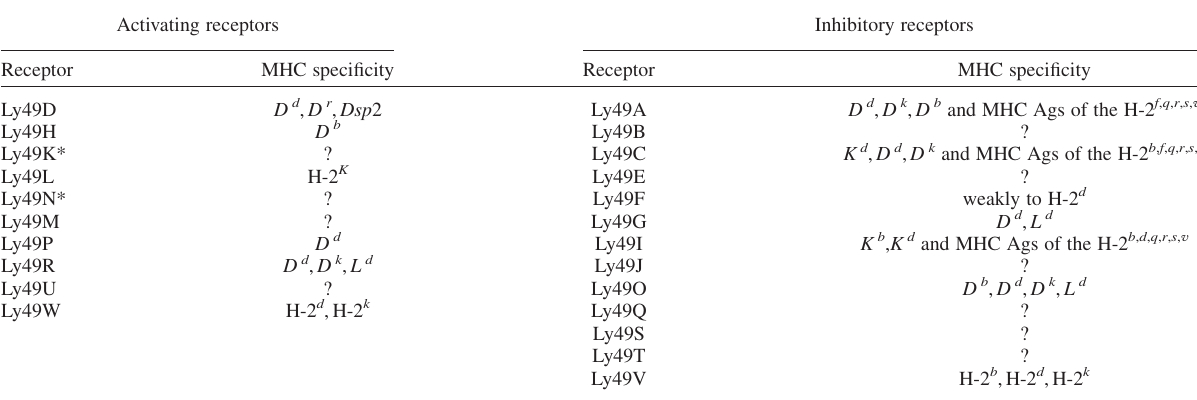
TABLE I The known MHC specificities of Ly49 receptors Activating